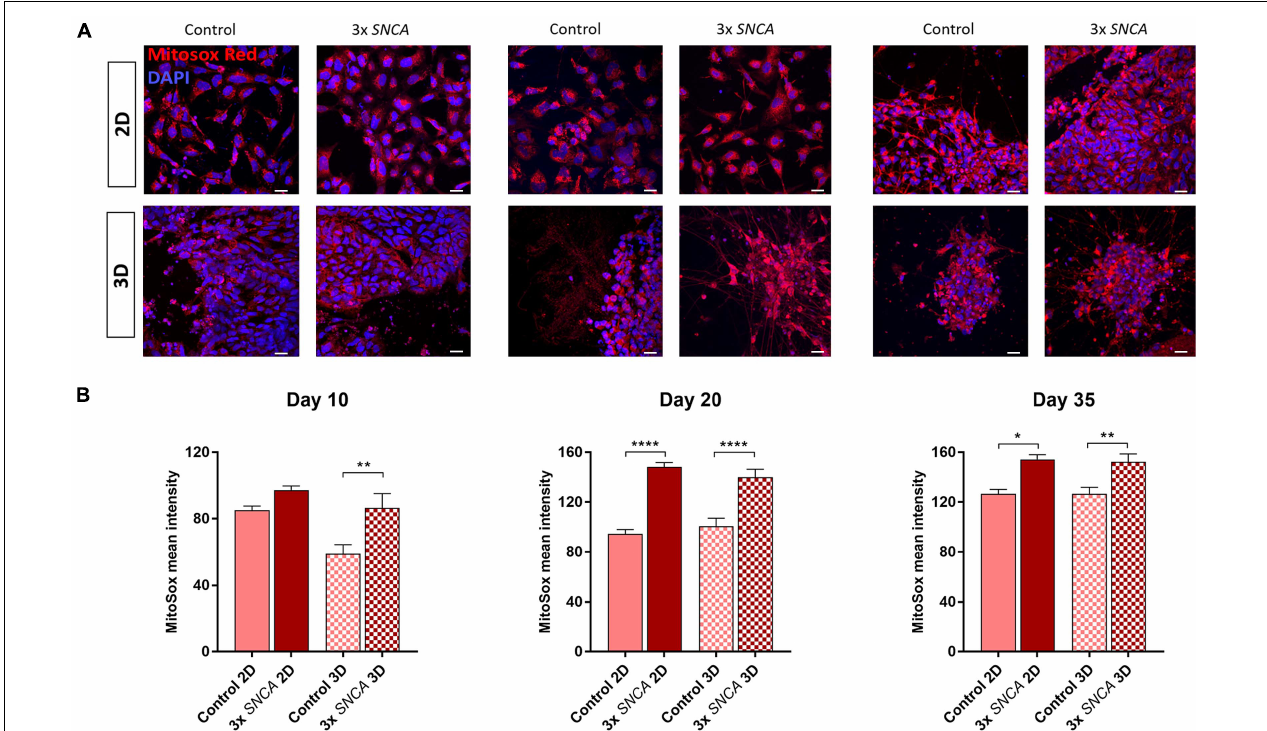
FIGURE 5 | Mitochondrial superoxide levels (mROS) quantified with the fluorogenic dye MitoSox Red in 2D and 3D cultures. (A) Representative fluorescence images at different time points. (B) Quantification of MitoSox intensity (mean ± SEM) in DA neurons differentiated from a control and a PD patient (3x SNCA mutant) hiPSC line at days 10, 20, and 35 during neuronal differentiation. Data are derived from two independent experiments. Scale bars represent 50 µ m. Statistical differences were calculated by one-way ANOVA followed by Tukey’s post hoc test to correct for multiple comparisons * p ≤ 0.05, ** p ≤ 0.01, **** p ≤